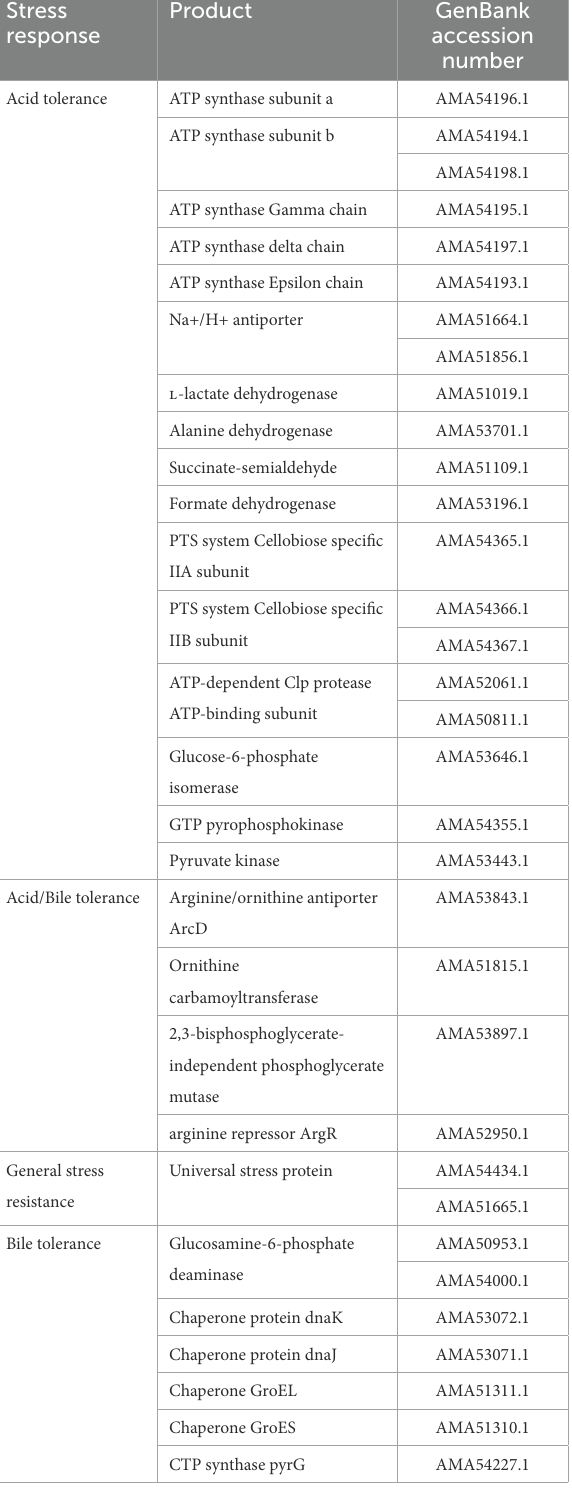
TABLE 2 Putative genes involved in gastric stress tolerance in DE111 ®